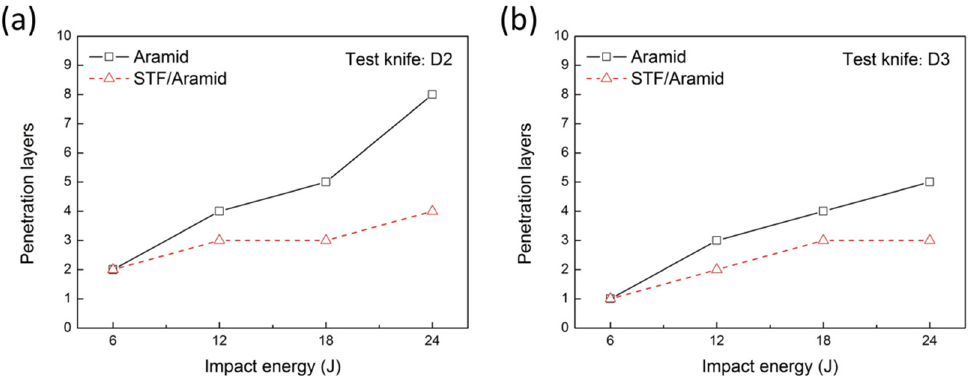
Figure 6. Relationship between fabrics’ penetration layers and impact energy. ( a ) D2 tool; ( b ) D3